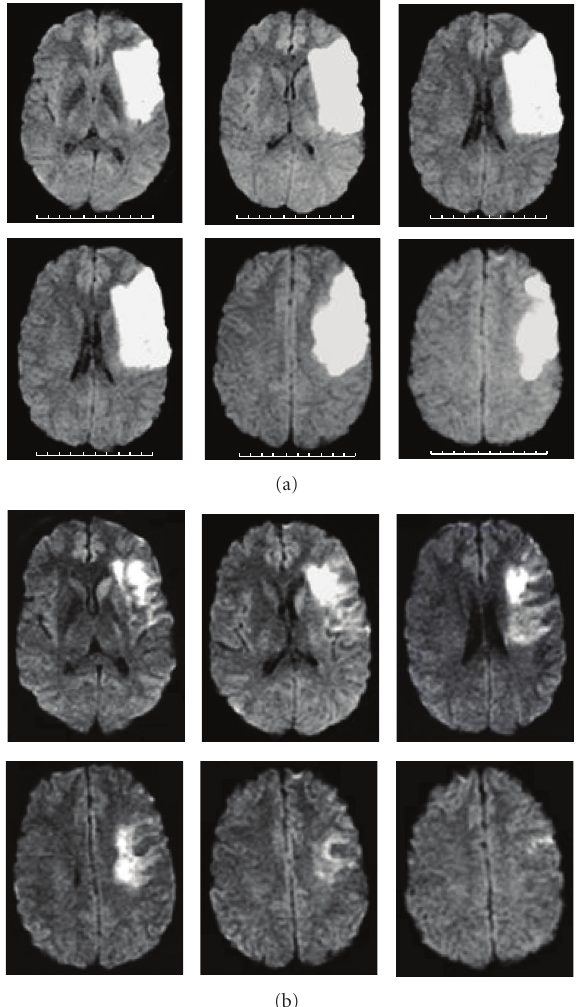
Figure 1: (a) Patterns of intracranial MCA blood flow velocities with time in both the right and left sides, before, during, and after (10 minutes and 48 hours) LBPP application. Note the left side improvement in systolic and diastolic blood flow velocity induced by LBPP, which was sustained for at least 2 days. (b) Vascular resistance index (RI) evolution (method for computation: systolic V/diastolic V). A clear di ff erence between right and left RI occurred only after 48 hours of LBPP application. Corresponding mean arterial pressure (mean AP) and heart rate (HR) at each time.